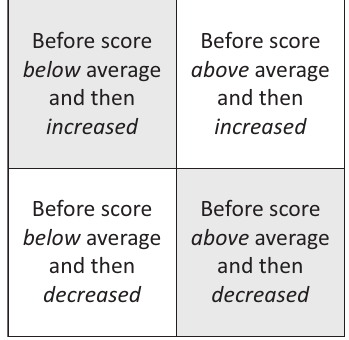
Figure 3. Guide to reading the scattergrams. For perceived self-efficacy, 23,13% had a score below the average on the first administration and their score on the second administrations indicated an increased perceived self-efficacy (top left quadrant). 31,25% of the young peo- ple had a score above the average on the first adminis-